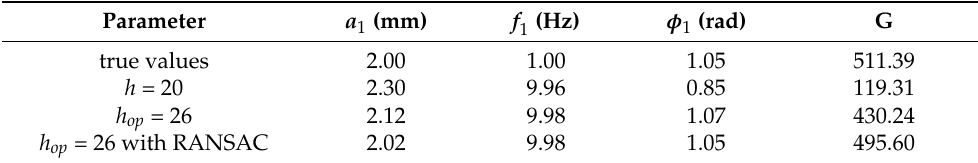
Table 2. Estimated parameter